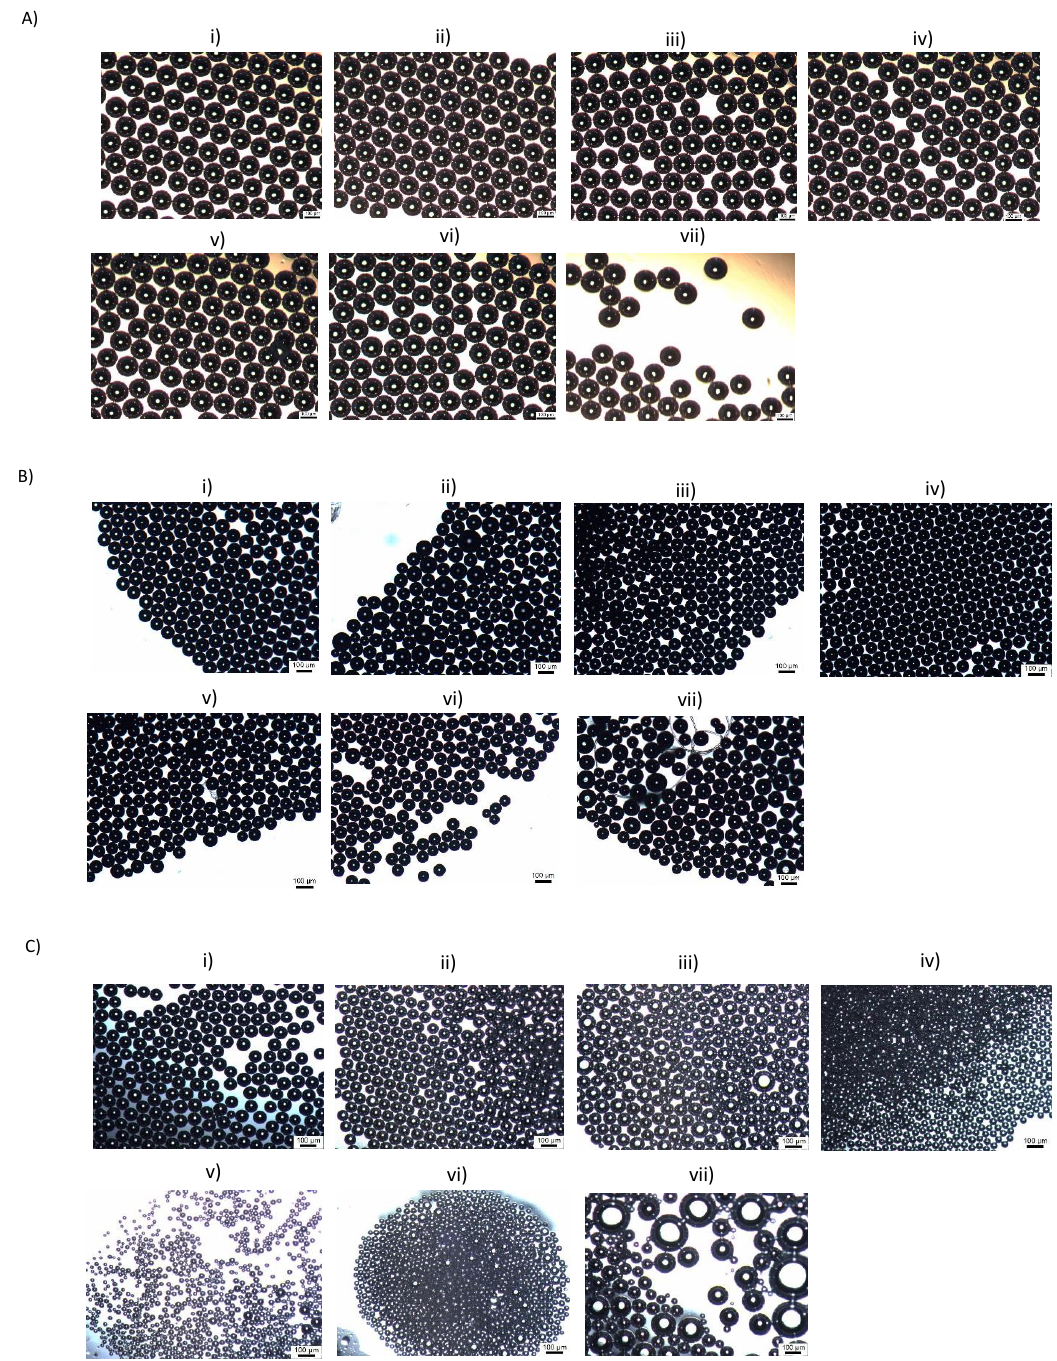
Figure 3. ( A ) Optical micrographs of bubbles obtained at a superimposed AC voltage of 2kV P–P, 100 Hz at applied DC voltages of ( i ) 0 V, ( ii ) 2 kV, ( iii ) 4 kV, ( iv ) 6 kV, ( v ) 8 kV, ( vi ) 10 kV, and ( vii ) 12 kV. ( B ) Optical micrographs of bubbles obtained at a superimposed AC voltage of 2kV P–P, 500 Hz at applied DC voltages of ( i ) 0 V, ( ii ) 2 kV, ( iii ) 4 kV, ( iv ) 6 kV, ( v ) 8 kV, ( vi ) 10 kV, and ( vii ) 12 kV. ( C ) Optical micrographs of bubbles obtained at a superimposed AC voltage of 2 kV P–P, 600 Hz at applied DC voltages of ( i ) 0 V, ( ii ) 2 kV, ( iii ) 4 kV, ( iv ) 6 kV, ( v ) 8 kV, ( vi ) 10 kV, and ( vii ) 12